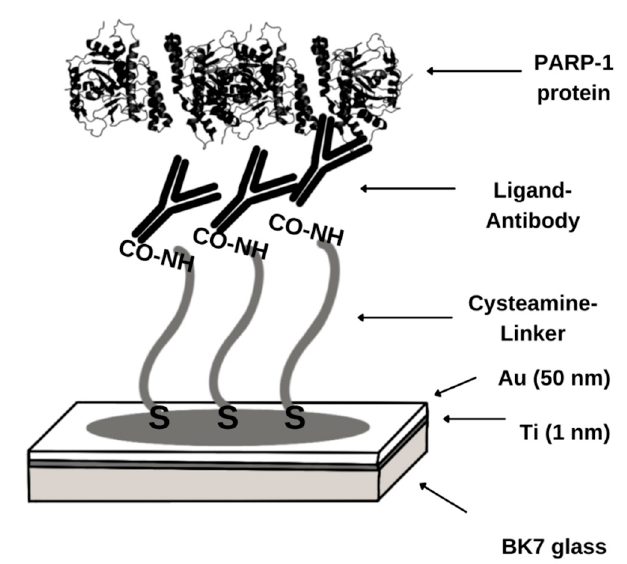
Figure A2. Diagram of the SPRi apparatus with its components.